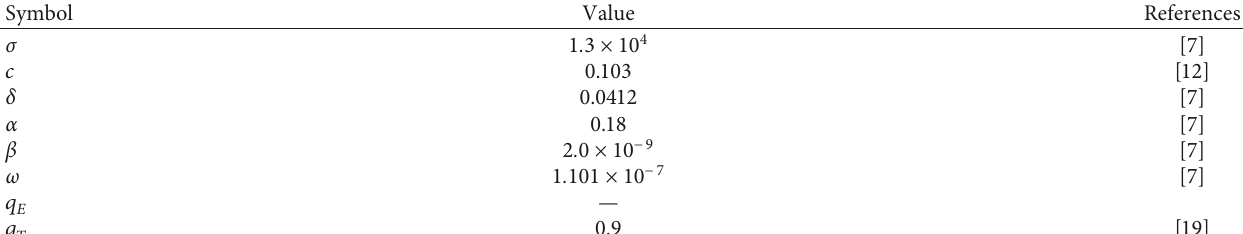
Table 2: Parameter values for model